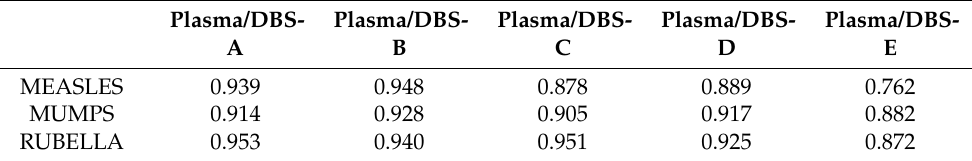
Figure 2. Comparison of DBSs and plasma results for measles, mumps and rubella processed after sample collection. DBS-A: DBSs eluted with a volume of PBS adjusted by hematocrit; DBS-B: DBSs eluted with 1 mL of PBS. Table 2. Spearman’s correlation coefficient between plasma and DBSs results.